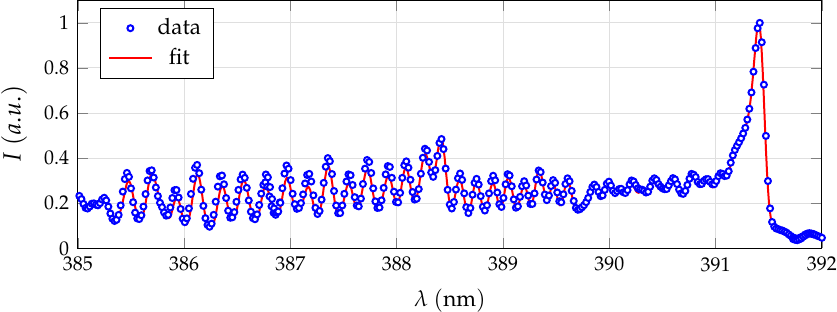
Figure 1. Rotational structure of a band sequence of the ( 0,0 ) -transition of the B 2 Σ + u of N + measured experimentally at peak current for the discharge operated at 60 kHz. Based on the calculated fit, a heavy particle temperature of 6300 K was estimated.